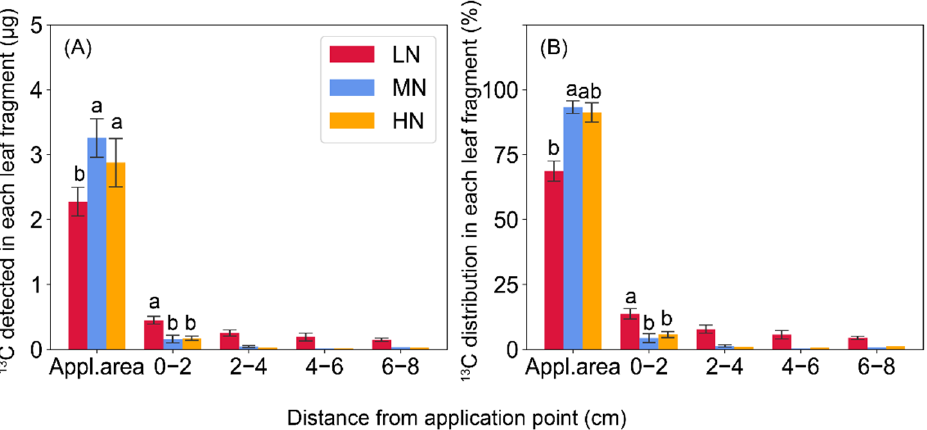
Figure 4. The absolute amount ( A ) and relative distribution ( B ) of 13 C in the 8th fully expanded leaf following foliar application of 13 C labeled sucrose at the leaf tip. Columns with no letter in common are significantly different between nitrogen treatments within each leaf fragment ( p < 0.05). Vertical bars indicate the standard error of the mean ( n = 4). Error bars are not shown for leaf fragments where 13 C was only detected in one or two of the four replicates. Appl. area means the application area of 13 C-sucrose labelled near the leaf tip.